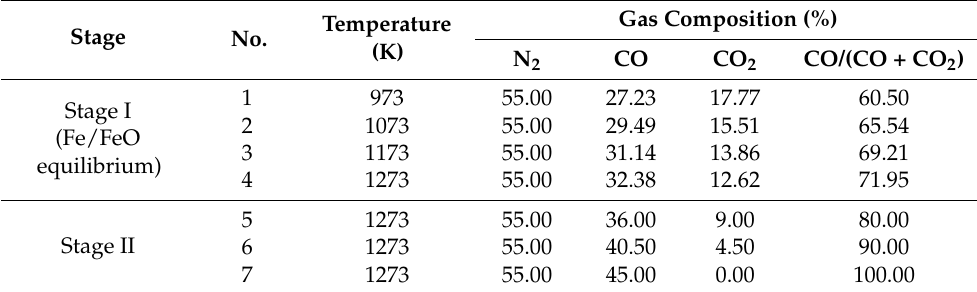
Figure 2. Schematic representation of the experimental apparatus. Table 2. Experimental conditions for the simulated blast furnace in the present study.